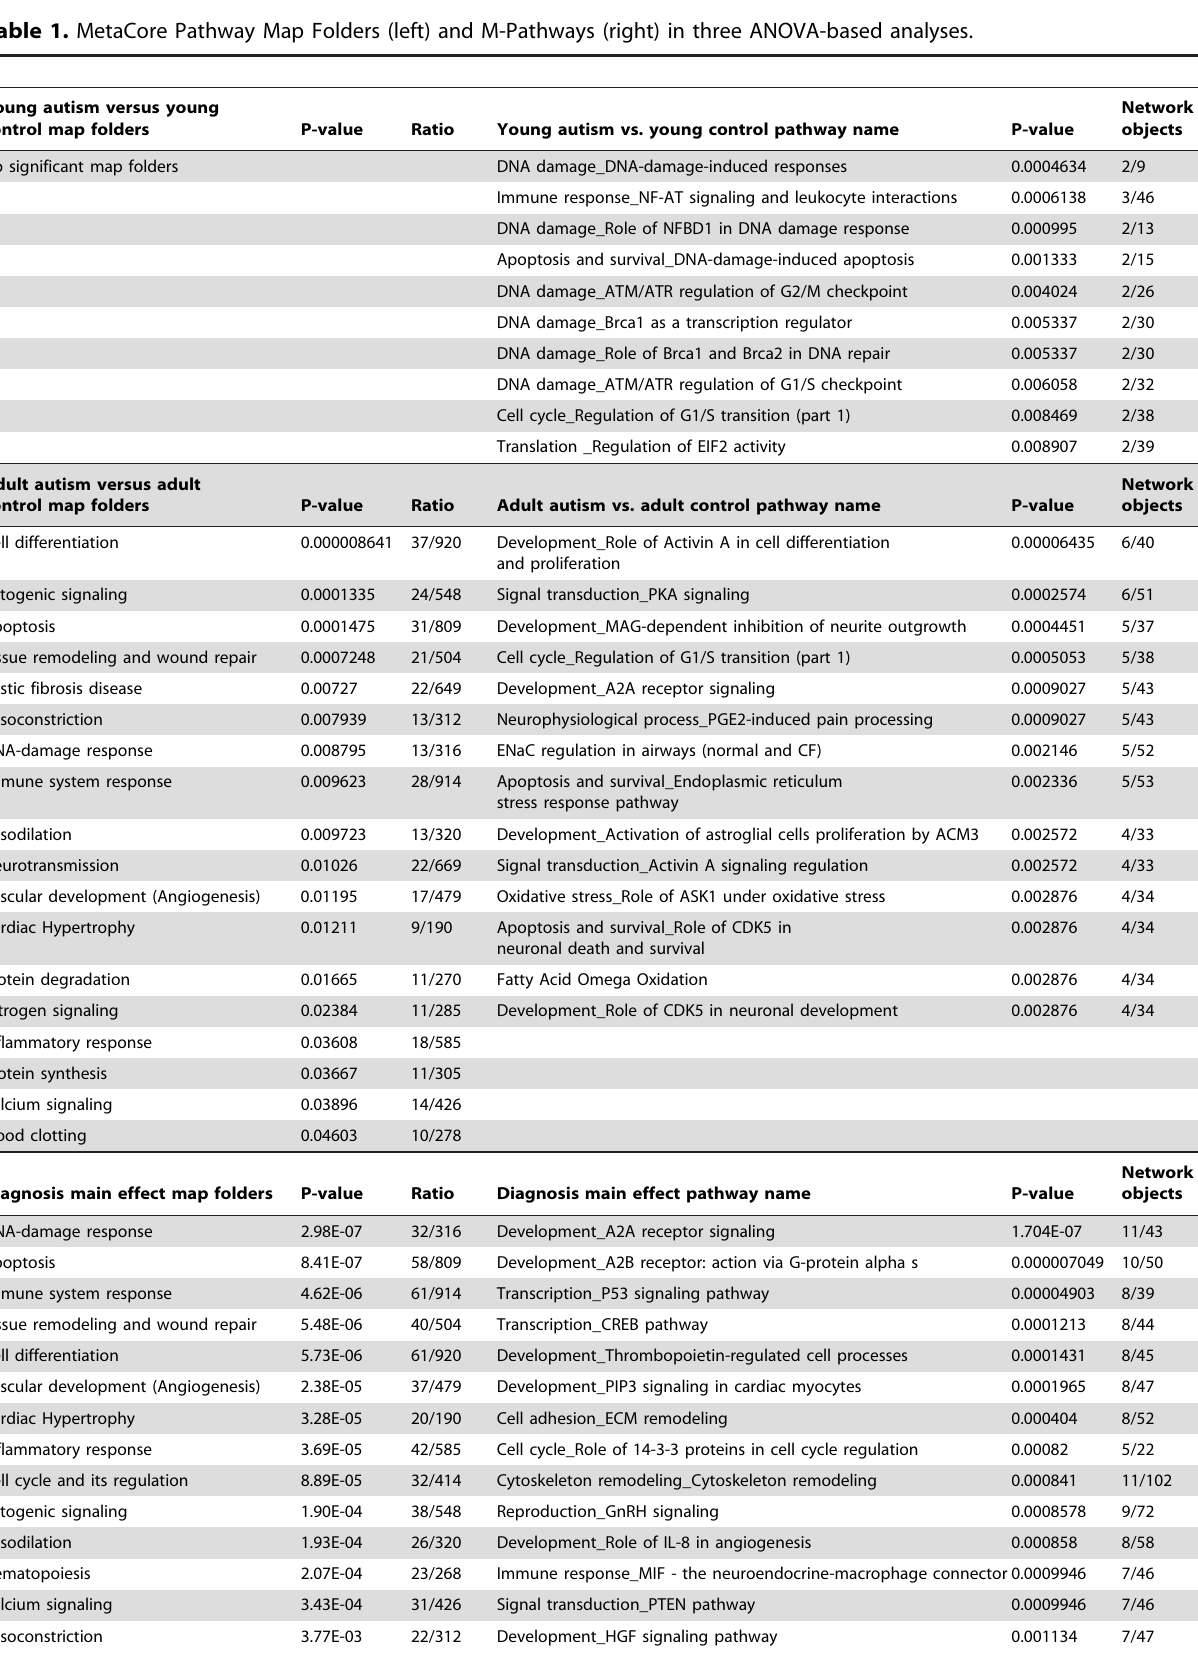
Table 1. MetaCore Pathway Map Folders (left) and M-Pathways (right) in three ANOVA-based analyses.